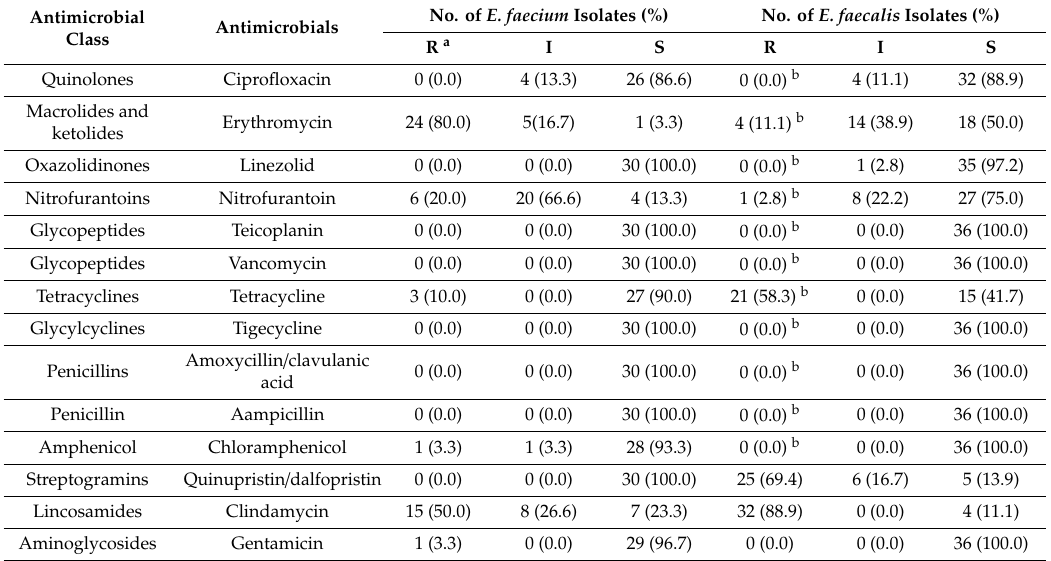
Table 2. Antimicrobial resistance of Enterococcus faecium and Enterococcus faecalis against 14 antibiotics. No. of E. faecium Isolates Antimicrobial Antimicrobials Class